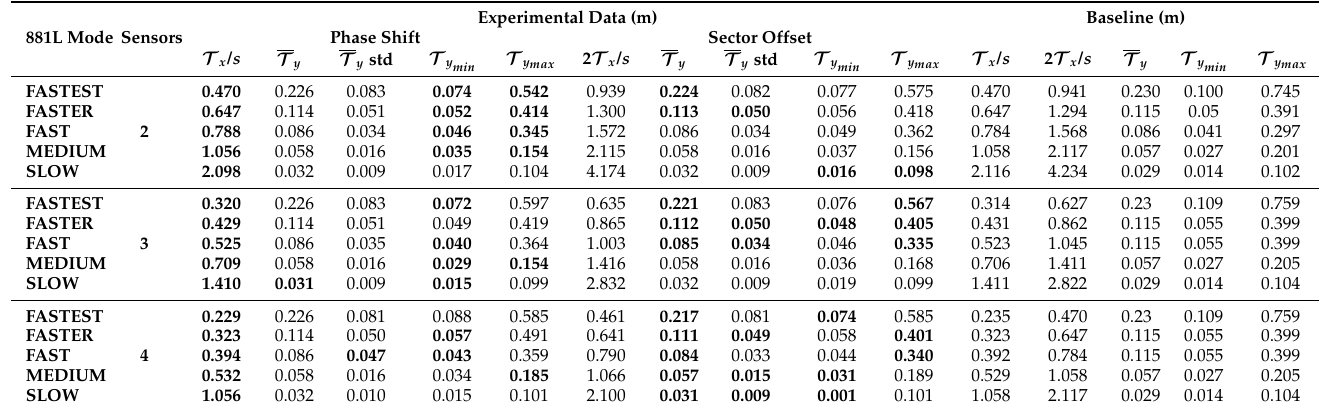
Table 4. Experiments for the range of 10 m considering 2, 3 and 4 881L sensors using VITA 2, comparison of Phase-Shift and Sector Offset, where s = nr. of sensors; T x / s = phase shift resolution along the tunnel length; 2 T x / s = sector offset resolution along the tunnel length. Numbers in bold indicate winning approach.